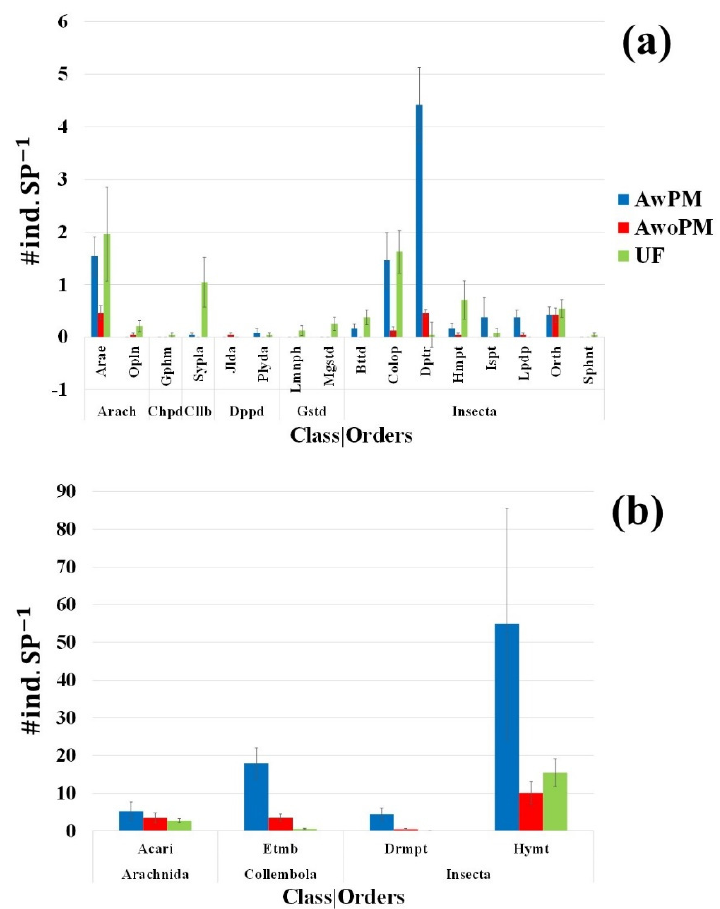
Figure 7. Composition of above-ground dwellers. Mean number of individuals per sampling point (#ind SP − 1 ) of ( a ) least dominant and ( b ) most dominant orders. Arach= Arachnida, Arae = Araneae, Bttd = Blattodea, Chpd = Chilopoda, Cllb = Colembolla, Colop = Coleoptera, Dppd = Diplopoda, Dptr = Dermaptera, Etmb = Entomobryomorpha, Gphm = Geophilomorpha, Gstd = Gastropoda, Hmpt = Hemiptera, Istp = Isoptera, Jlda = Julida, Lmnph = Limnophila, Lpdp = Lepidoptera, Mgstd = Mesogastropoda, Opln = Opiliones, Orth = Orthoptera, Plyda = Polydesmida, Sphnt = Siphonaptera, Sypla = Symphypleona. AwPM = agriculture with plastic mulch and GLY; AwoPM = agriculture without plastic mulch and the use of GLY; UF = unmanaged farming system: SP = sampling point.